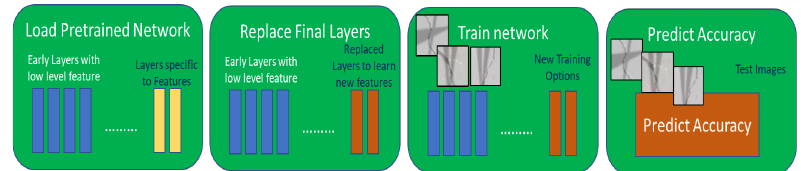
Figure 7. Workflow showing retraining of a pretrained network.